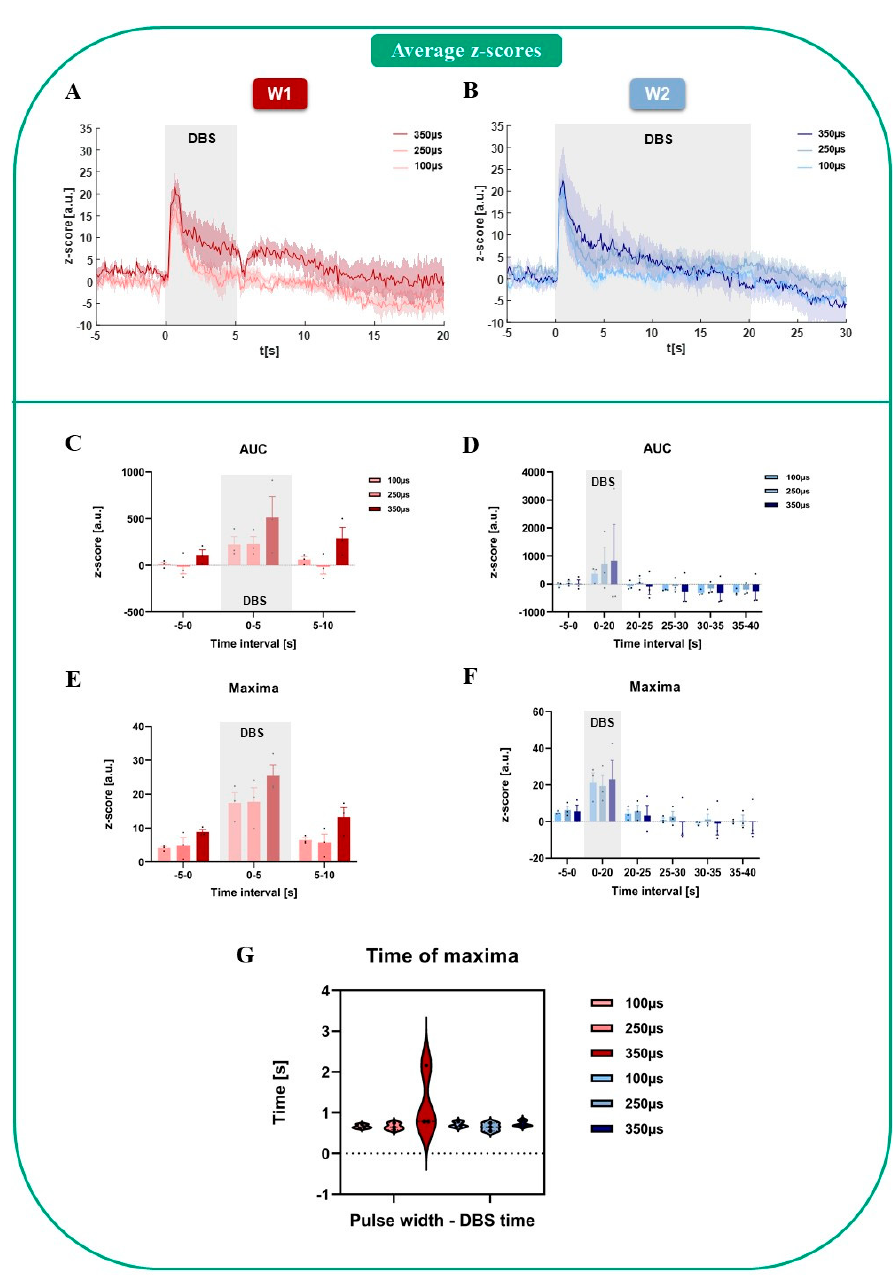
Figure 2. ( A ) Average dopamine profiles ( n = 3) for 5 s DBS (week 1 (W1)) and all PWs (100, 250 and 350 µ s). ( B ) Average dopamine profiles ( n = 3) for the 20 s DBS (week 2 (W2)) and all PWs (100, 250 and 350 µ s). ( C ) Area under the curve (AUC) for the baseline period ( − 5–0 s), 5 s stimulation (0–5